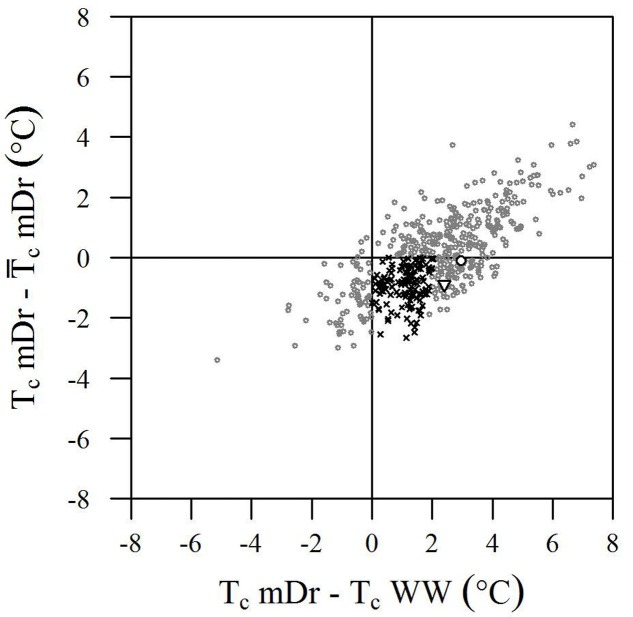
Biplot of genotype performance in response to drought stress. The difference between genotypic mean Tc (°C) and POP6 mean Tc in mDr is plotted against the difference between genotypic mean Tc in mDr and WW conditions. Genotypes are indicated with gray circles. White circles and white triangles correspond to Poli and 58-861, respectively. Black crosses indicate genotypes with (TcmDr – cmDr) less than 0 (genotypes are less stressed than the average POP6 response), and whose stress susceptibility index (SSI, defined in Section “Stress Susceptibility Index”) lies between 0 and 1 (the temperature increase in mDr with respect to WW in the genotype is lower than the temperature increase observed in the population). Such genotypes suggest an improved response to drought stress as compared to the overall population behavior.